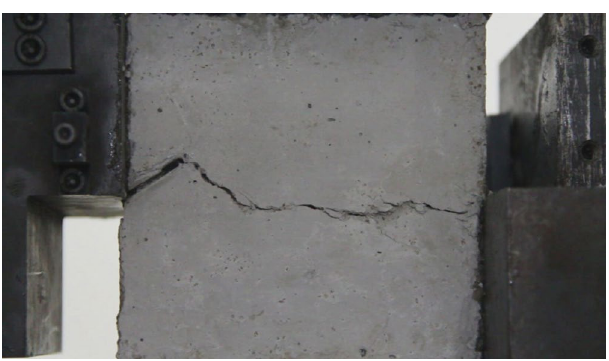
Figure 61. Photograph showing penetration patterns of the tip of the left crack and the right boundary are connected.